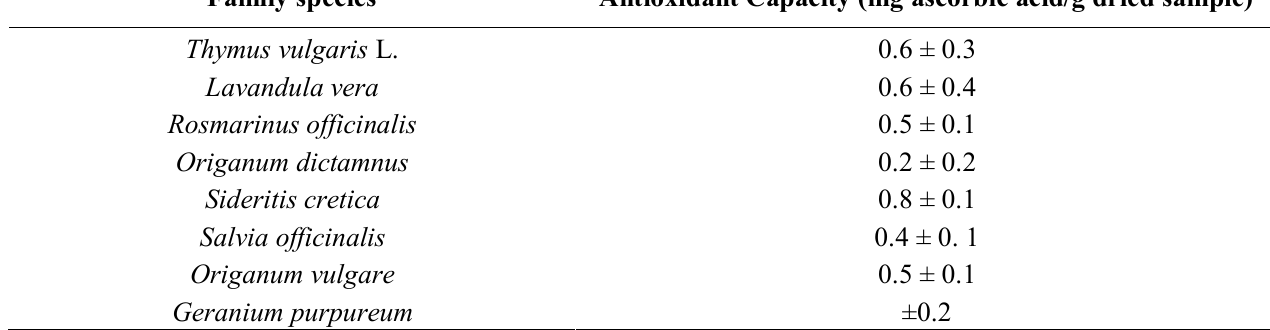
Table 3. Antioxidant capacity of plant